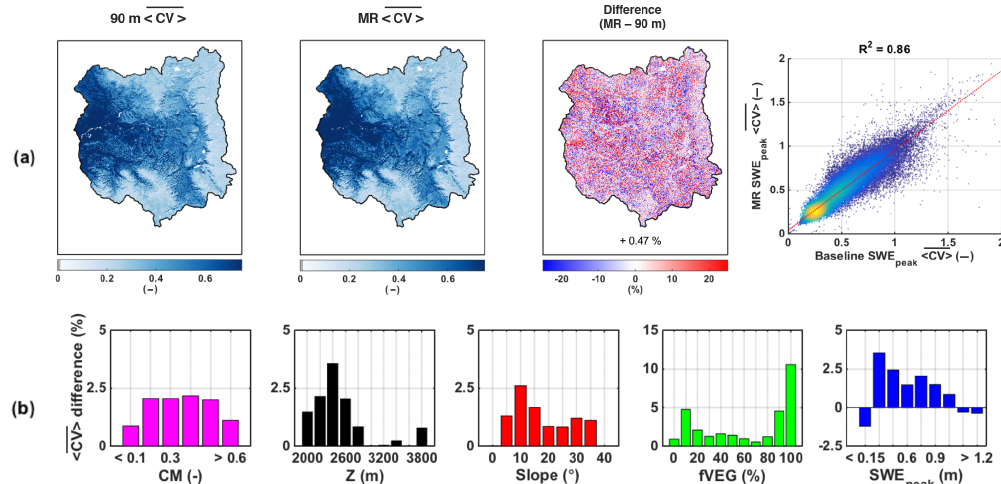
Figure 11. (a) Maps of pixel-wise 31-year-average SWE peak coefficient of variation ( < CV > ) over the upper Yampa River basin for the 90m baseline, the MR case, the percentage difference between the two approaches (MR − baseline), and the corresponding scatter plot. (b) Distribution of < CV > relative difference with complexity metric (CM), elevation ( Z ), slope, forested fraction (fVEG), and SWE peak . Pixels with a 31-year-average SWE peak lower than 5cm were discarded from the